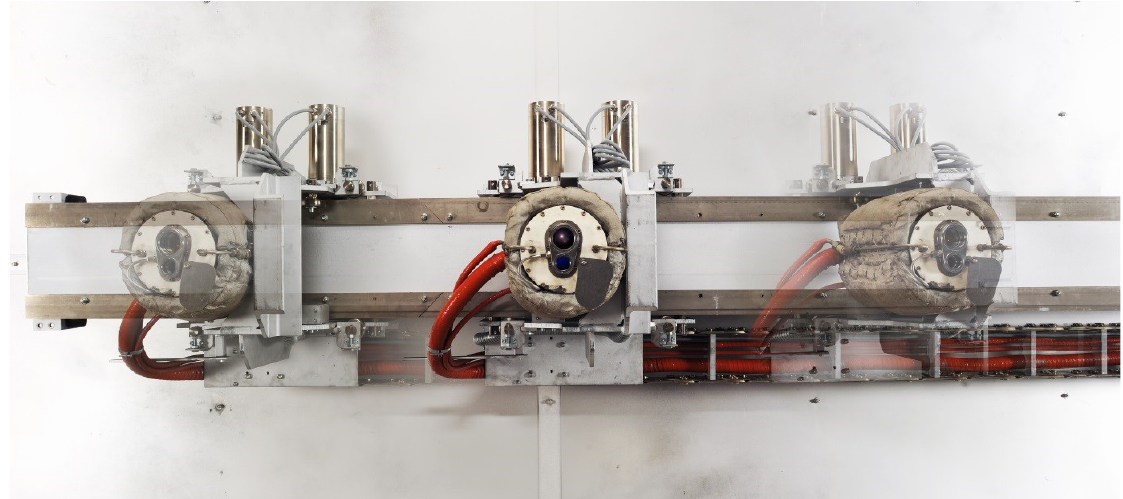
Figure 4: Thermography system inside the autoclave.